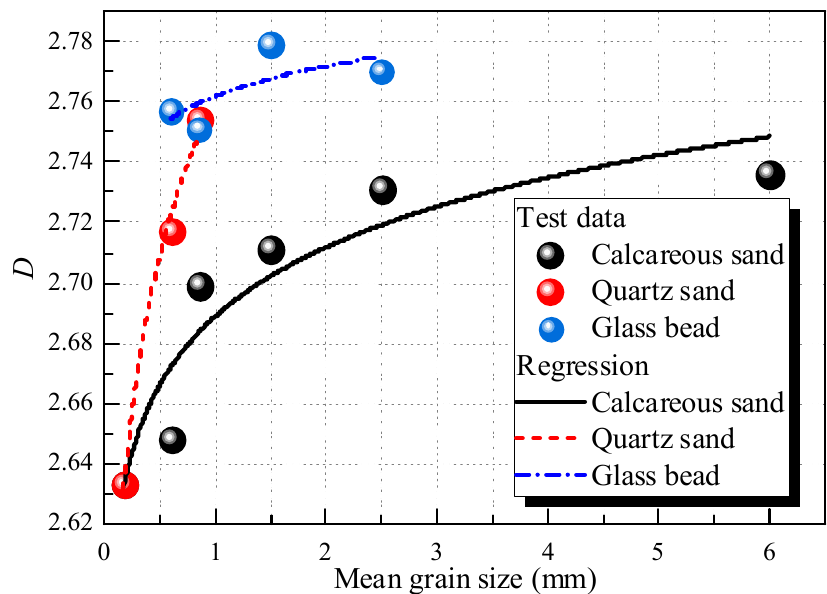
Figure 10. Determination of fractal dimension of glass bead with different grain sizes: ( a ) 0.5–0.71